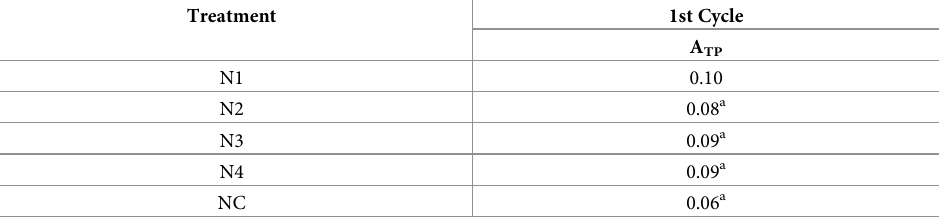
The treatment averages followed by the letter (a) did not differ from the NC control by the Dunnett’s test at the 5% level of significance. A TP —accumulation of total phosphorus in aerial part of plants